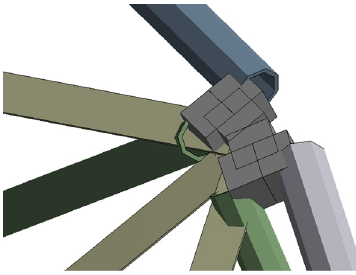
( 14 ) Figure 7: FE representation of the hinge